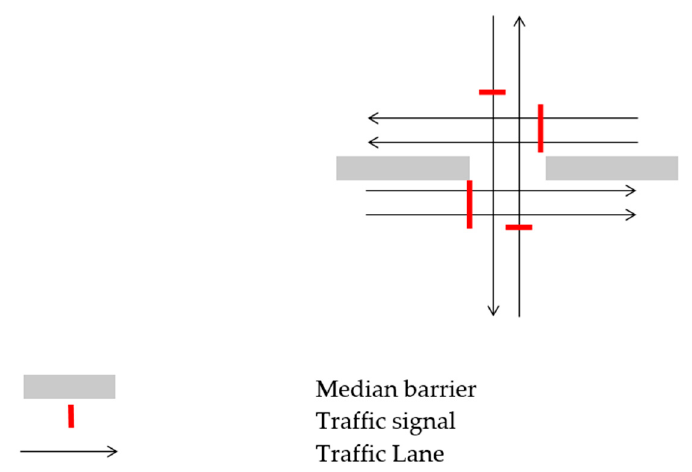
Figure 2. Schematic visualization of the typical lay-out of the selected intersections.